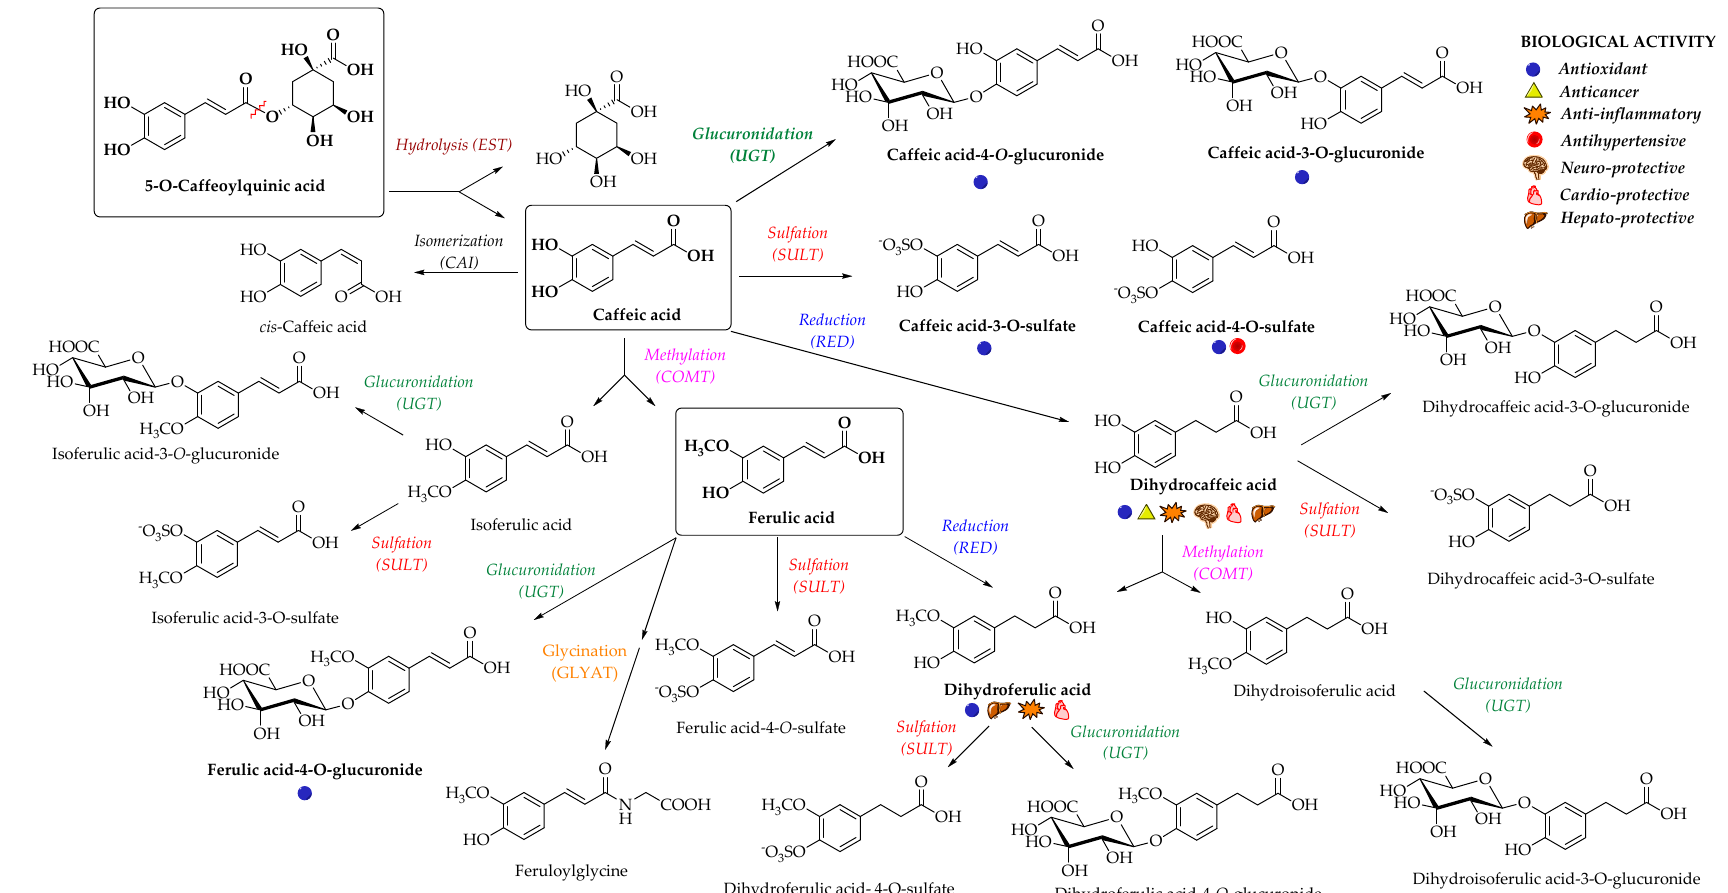
Figure 3. Proposed metabolic pathways and metabolites of 5-O-caffeoylquinic, caffeic and ferulic acids; EST, esterase; CAI, caffeic acid isomerase; RED, reductase; COMT, catechol- O -methyltransferase; SULT, sulfotransferase; UGT, uridine-5 ′ -diphosphate-glucuronosyltransferase; GLYAT, glycine-N-acyltransferase [52,70,71]. The main biological activities of selected metabolites are presented with appropriate symbols.